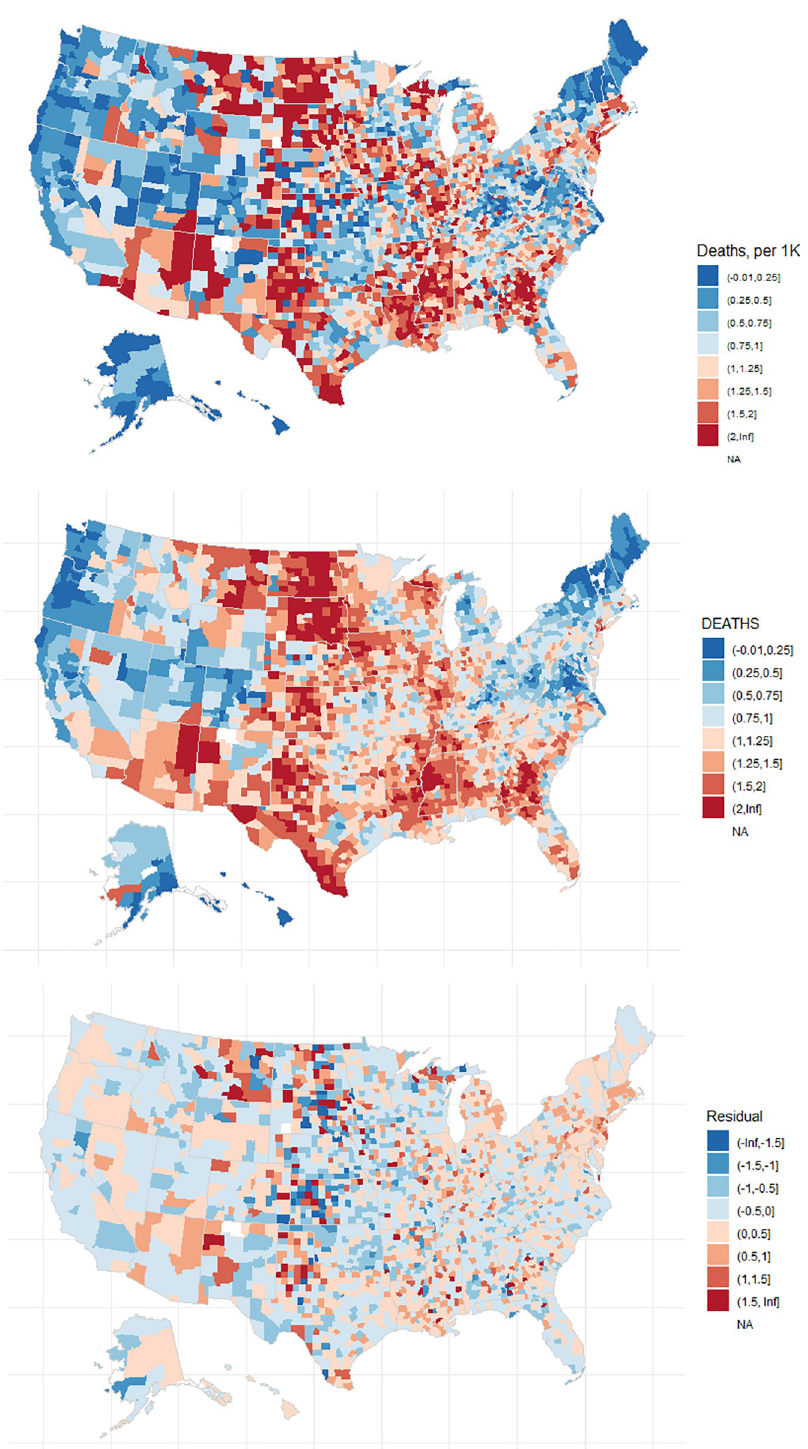
Fig 7. Observed death rate (as in Fig 2), model fit, and residual of the spatial lag model. Maps generated with usmap R package